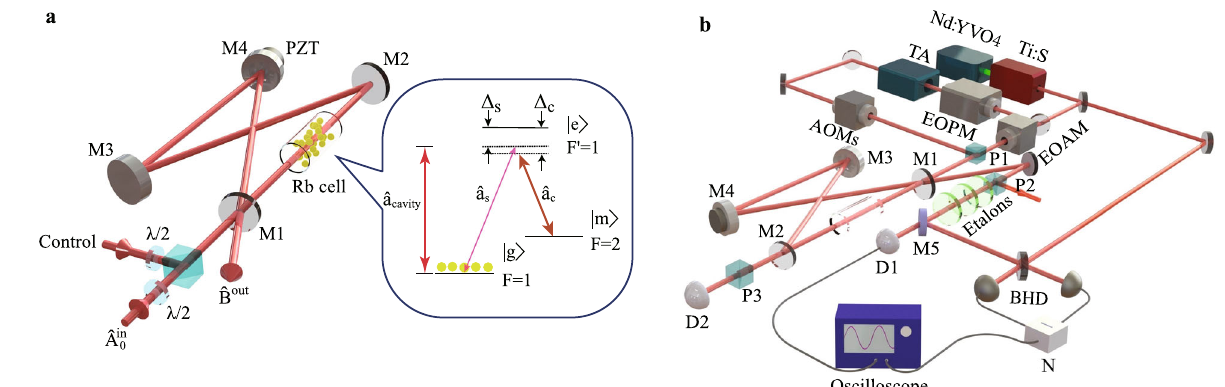
Fig. 1 Schematic diagram. a Diagram for the cavity-enhanced quantum memory and atomic energy level for quantum memory. Atoms with a ground state are shown. The atomic cell is placed between two plano mirrors, where the optical cavity simultaneously enhances the light-atom interaction and suppresses the excess noise. b Experimental setup